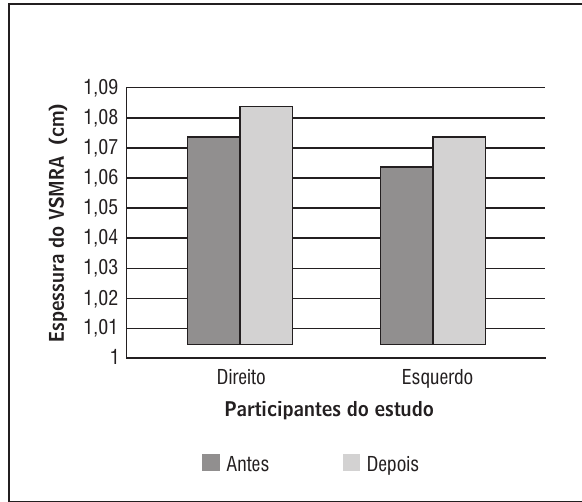
Gráfico 1 - Média da espessura do VSMRA, observada nos lados direito e esquerdo, antes e após trinta sessões de estimulação com Corrente